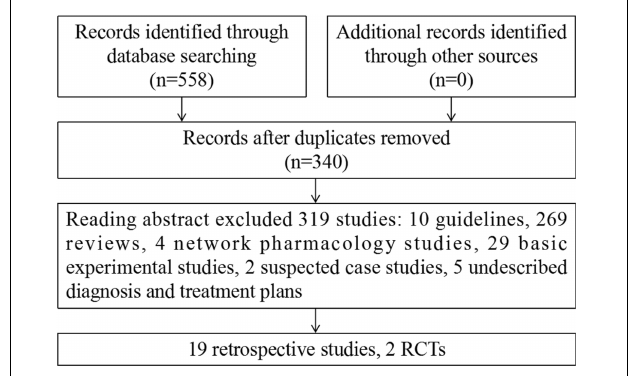
FIGURE 1 | Flowchart of including and excluding